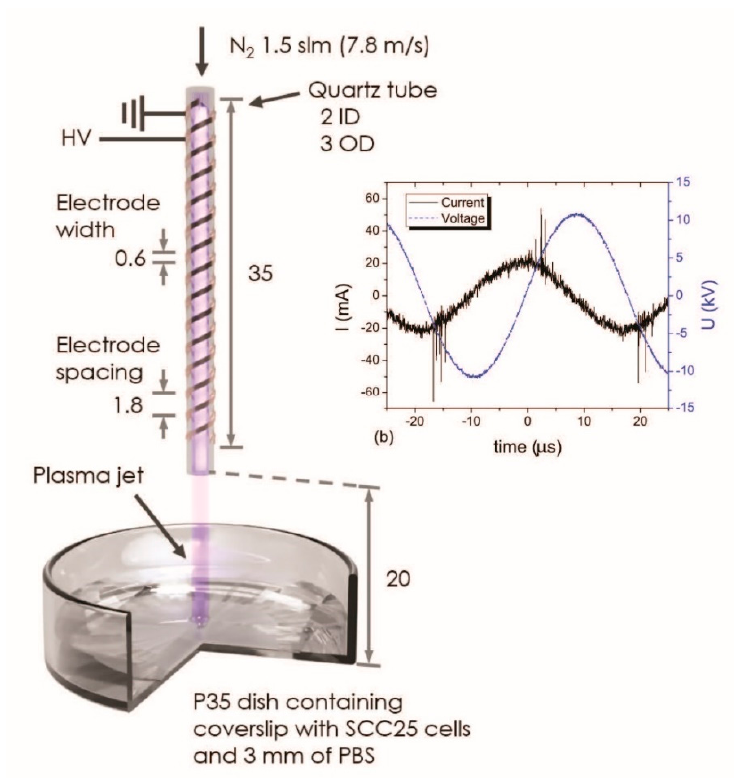
Figure 4. A schematic diagram of the nitrogen APPJ source used to treat cultured cells on coverslips. All dimensions are in mm. The inset shows the high voltage (HV) and current of alternating current (AC) waveforms of the nitrogen APPJ